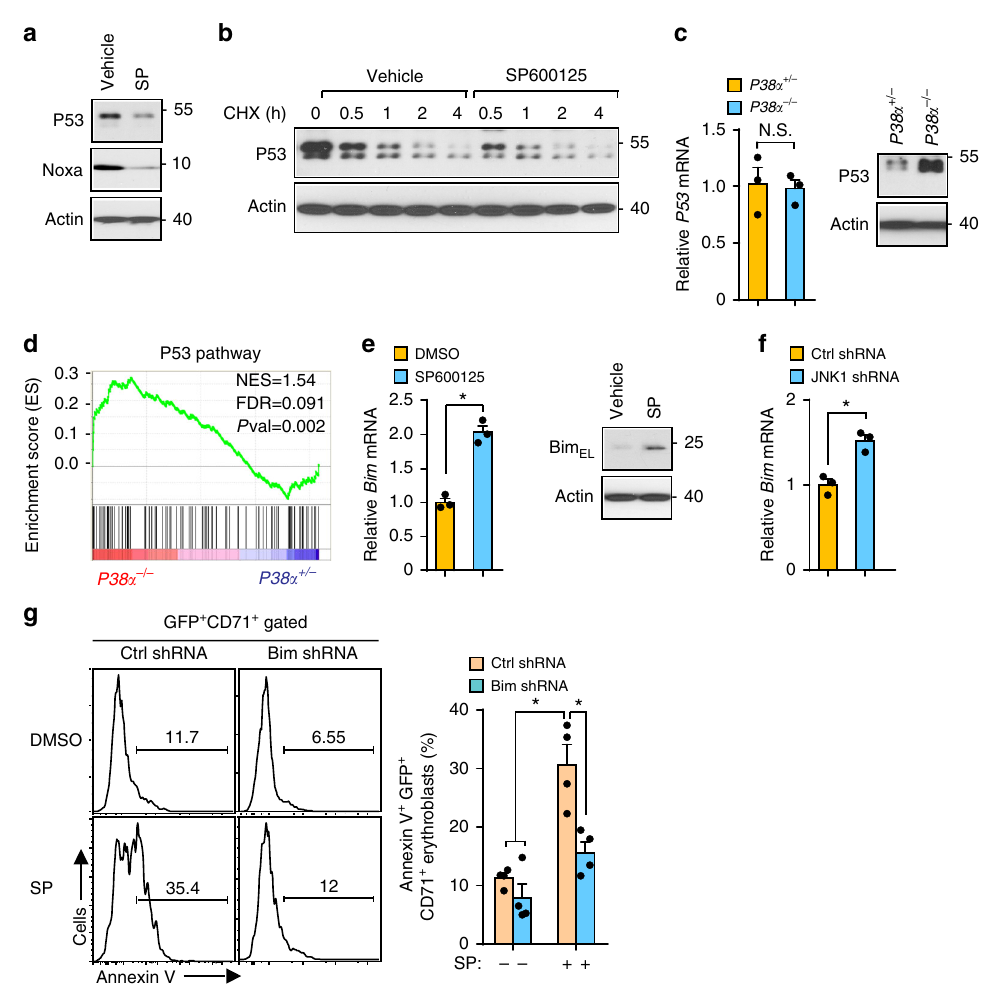
Fig. 4 Bim but not P53 modulates erythroblast apoptosis downstream of JNK. a Human erythroblasts treated with DMSO or SP600125, P53 and Noxa expression measured by immunoblotting. b Time course of P53 protein expression in human erythroblasts treated with DMSO or SP600125 in the presence of cycloheximide (CHX). c P53 mRNA (left) and protein (right) level in P38 α + / − and P38 α − / − erythroblasts measured by q-PCR or western blot. d GSEA analysis of P53 pathway in P38 α + / − and P38 α − / − erythroblasts. e mRNA (left) and protein (right) level of Bim in human erythroblasts triggered by SP600125 at 12 h by q-PCR or immunoblotting. f Bim mRNA expression in human erythroblasts induced by JNK1 shRNA. g Representative fl ow plots (left) and Quanti fi cation (right) of SP600125-induced apoptosis of human erythroblasts transduced with control or Bim-speci fi c shRNA ( n = 4). Blots are representative of three independent experiments. Data are shown as mean ± s.e.m. * P < 0.05 (two-tailed unpaired Student ’ s t